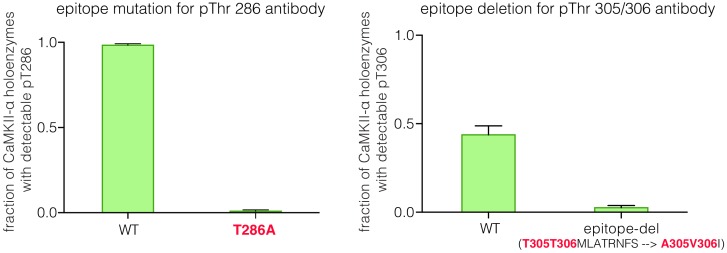
Validation of phosphospecific antibodies.Mutation/deletion of epitopes for pThr 286 (left) and pThr 305/306 (right)-specific antibodies leads to no detection of phosphosignal at the respective sites.